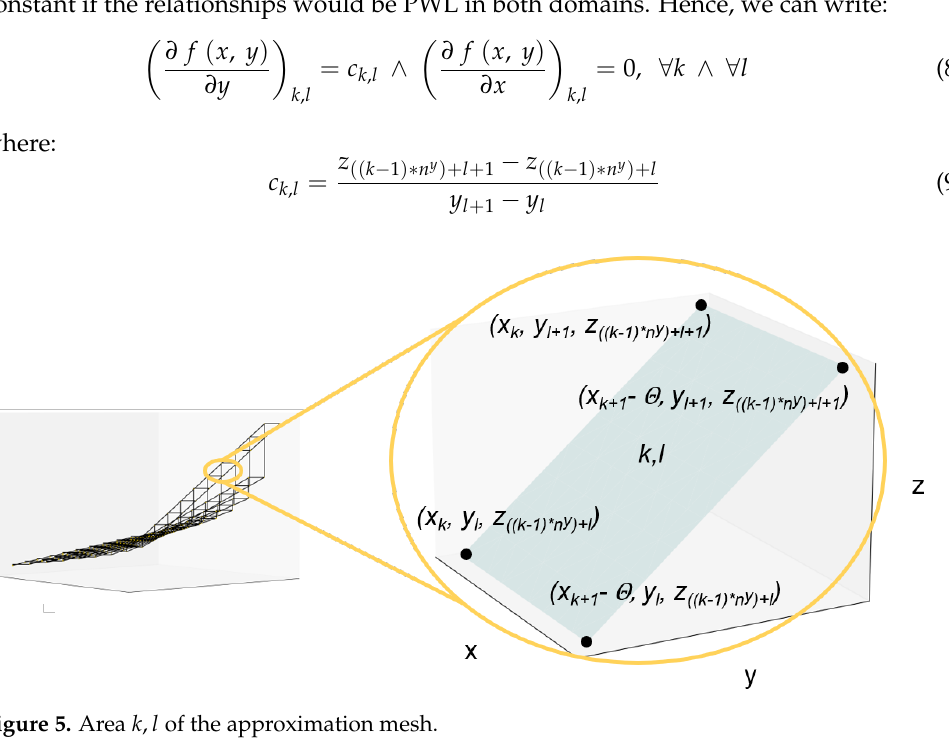
Figure 5. Area 𝑘, 𝑙 of the approximation